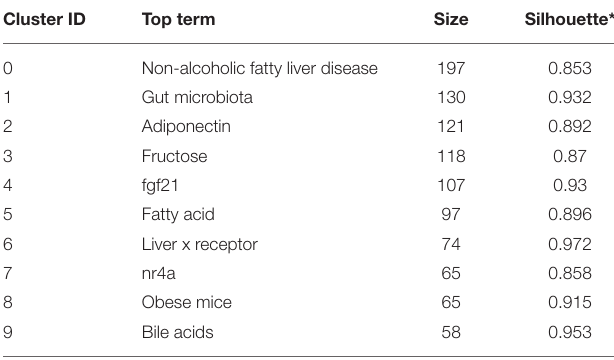
TABLE 3 | A summary of 10